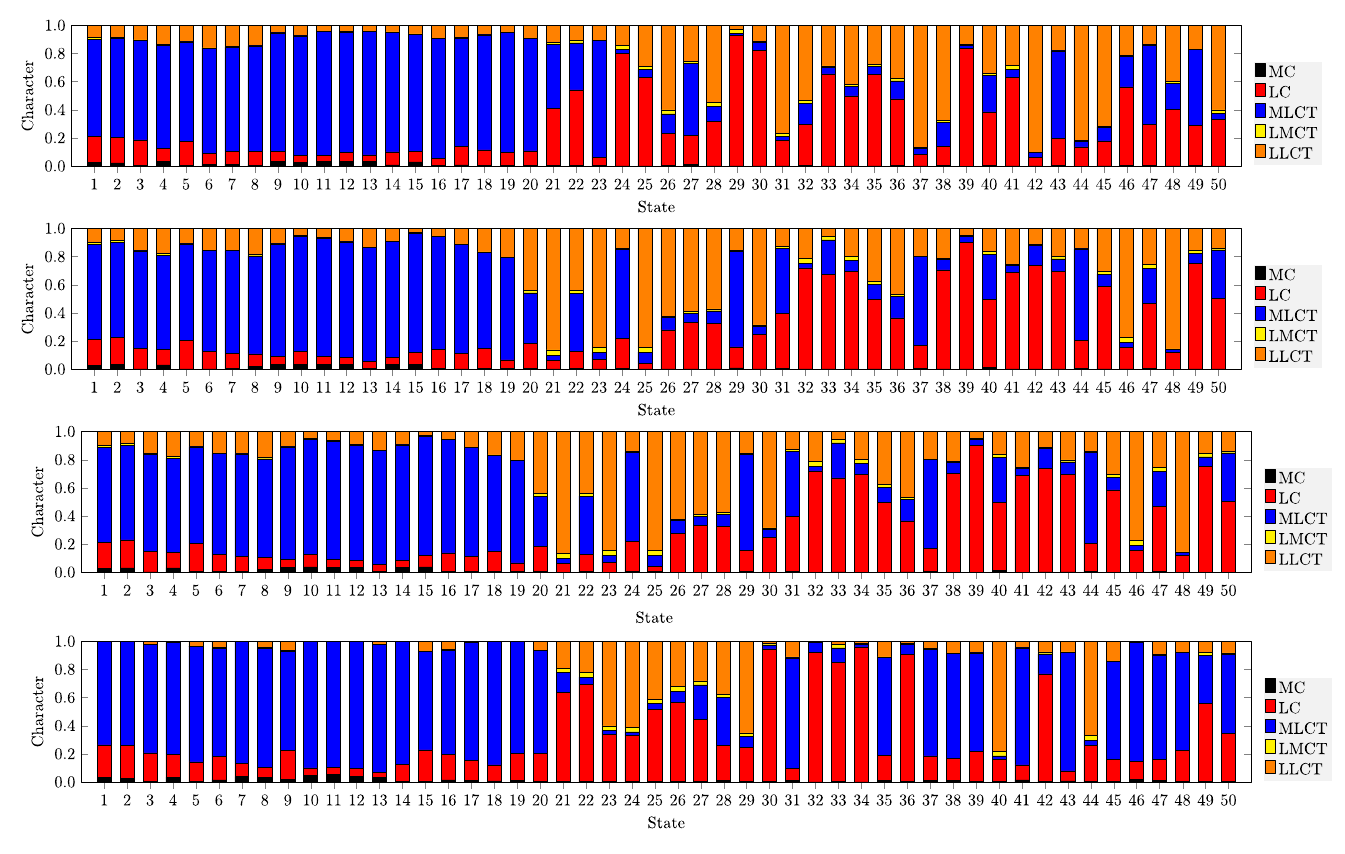
Figure 8. TheoDORE analysis of C2 , C3 , C4 and C6 , respectively, showing the nature of the singlet transitions in the calculated absorption spectra.